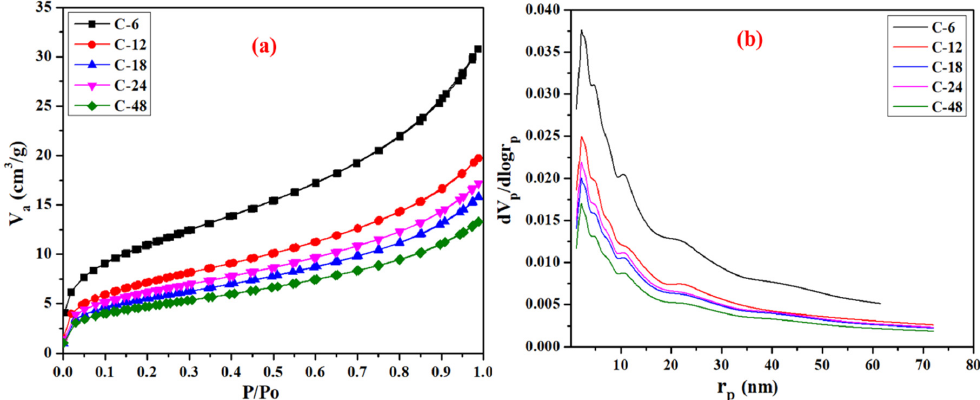
Figure 6. N 2 adsorption-desorption isotherms ( a ) and pore-size distribution curves ( b ) of CdS nanorod samples prepared at different reaction times.